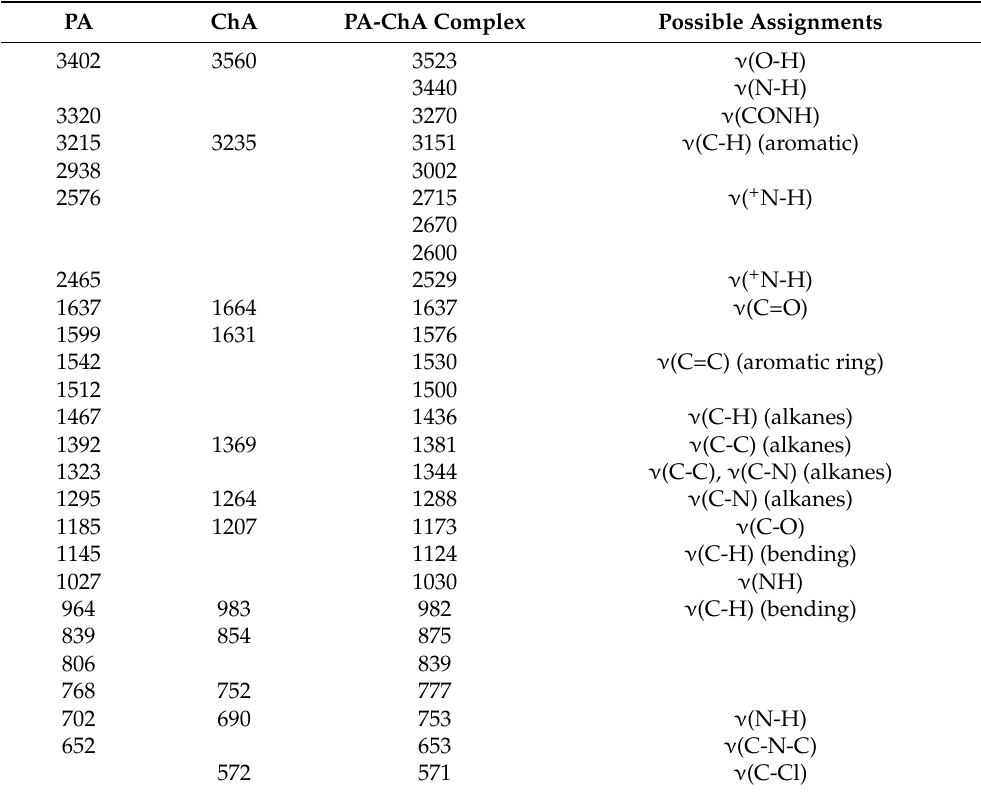
Table 2. IR spectral bands of PA, ChA, and their complex (PA-ChA). PA ChA PA-ChA Complex Possible